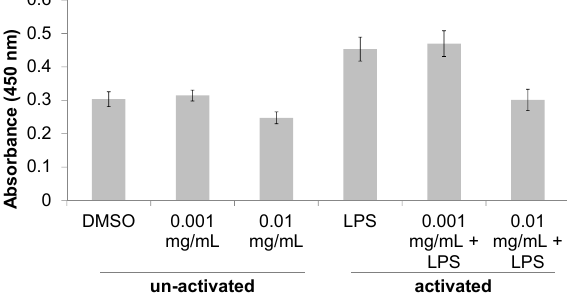
Figure 1. Cell proliferation activity of T. lanatum extract. The number of viable macrophage cells was determined by measuring the absorbance of cell cultures following the addition of tetrazolium dye, WST-8. Cells treated with DMSO (non-activated) were used as negative controls and cells treated with LPS (activated) were used to represent a pro-inflammatory response. Results of ANOVA suggest that activation of macrophages significantly affected cell proliferation ( P activation = 5.81 × 10 − 9 ) and that treatment with T. lanatum extract significantly altered cell proliferation ( P interaction = 3.16 × 10 − 3 ). Error bars represent ± one standard deviation from the mean response.